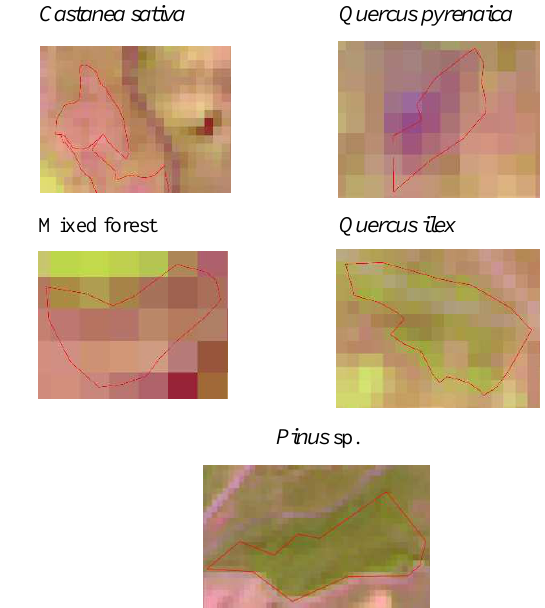
Figure 2. Sentinel band combination (11/8A/4) for images obtained in different months in the Municipality of Folgoso do Courel. (a) March (b) May (c) July (d) September